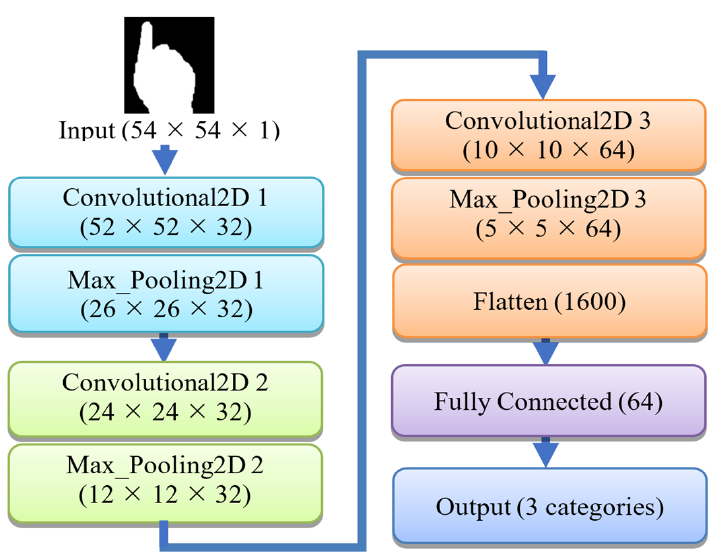
Figure 4. Architectural layers of the proposed CNN Model.